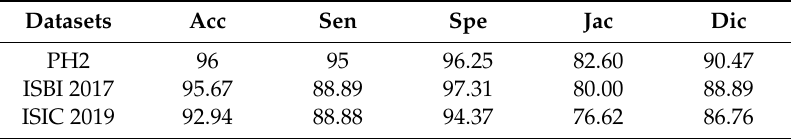
Figure 13. ( a ) Input images (IMD285, ISIC_0013617 and ISIC_0059197), ( b ) output image after hair removal and enhancement, ( c ) location detection by YOLOv3, ( d ) segmented image after iteration I, ( e ) segmented image after iteration II (final segmented output). Table 7. Segmentation performance (%) of iteration